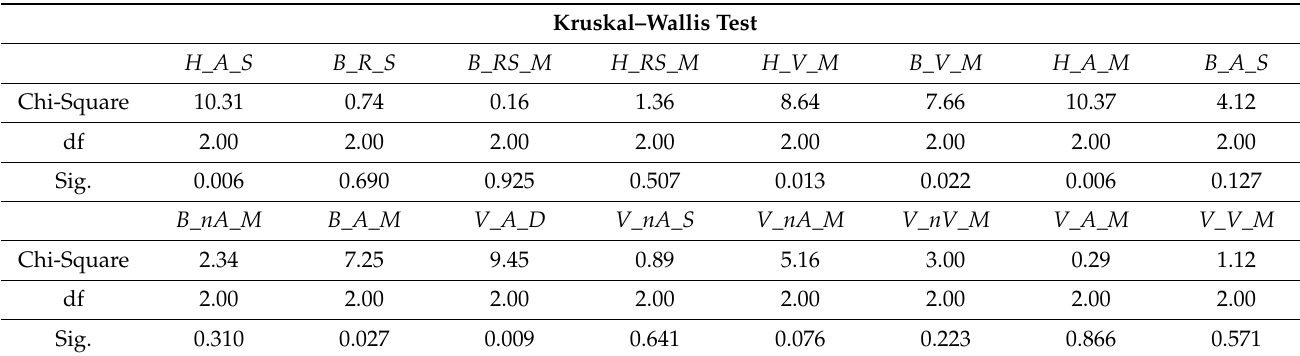
Table 4. The general differences in the temporal structure of the reverse punch between the strikes classified as fast, average, and slow in relation to the achieved maximal hand velocity.